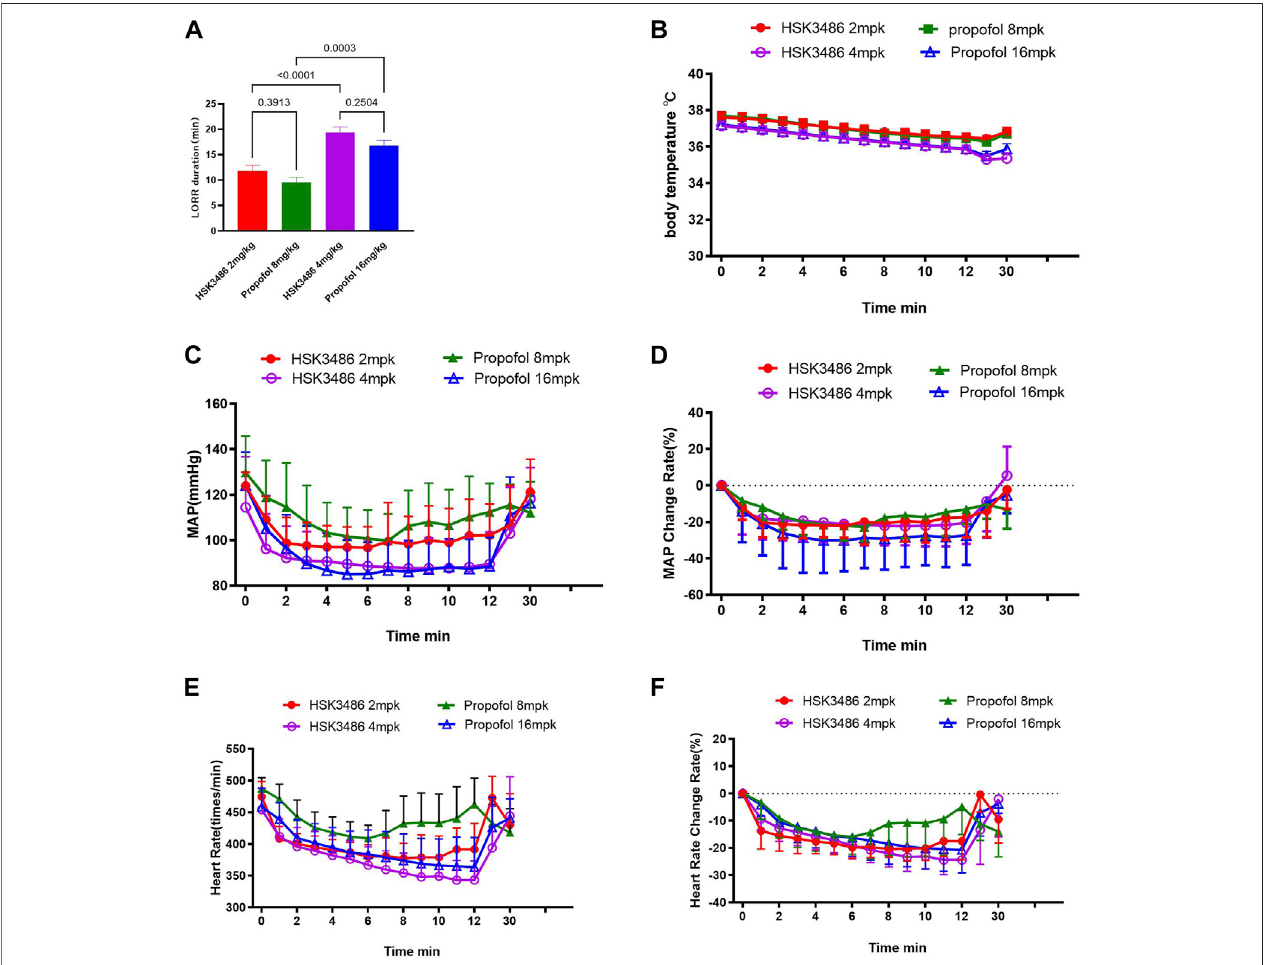
FIGURE 2 | Telemetry measurements in rats after intravenous bolus injection of HSK3486 or propofol. (A) Duration of the loss of righting re fl ex (LORR). (B) Body temperature. (C) Mean arterial blood pressure (MAP). (D) Change in MAP rate. (E) Heart rate. (F) Change in heart rate. Data are mean ± SD.